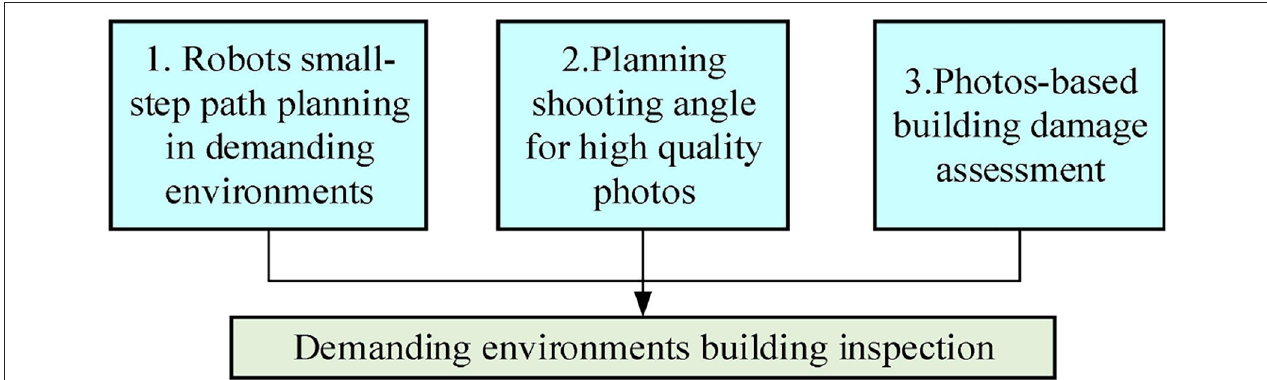
FIGURE 2 | Robots utilized to inspect and evaluate the building damage for safety